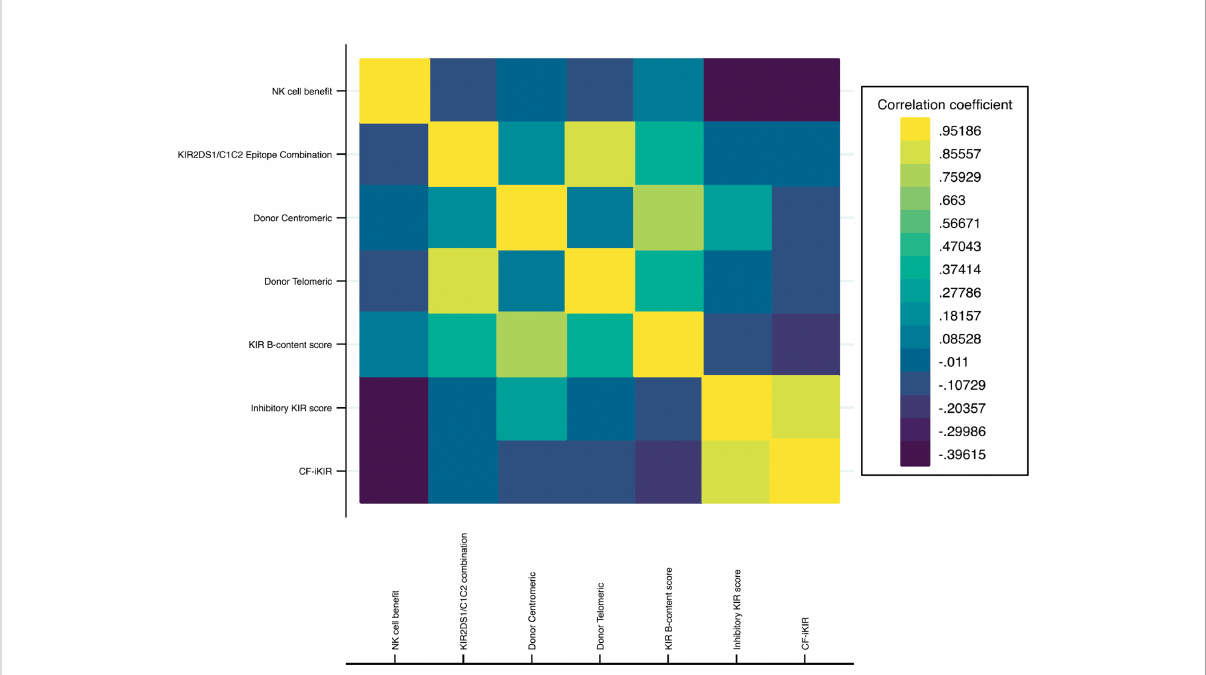
FIGURE 1 Correlation heatmap of NK cell alloreactivity models. Abbreviations: NK cell, natural killer cell; KIR, killer cell immunoglobulin-like receptor; CF- iKIR score, count functional inhibitory KIR